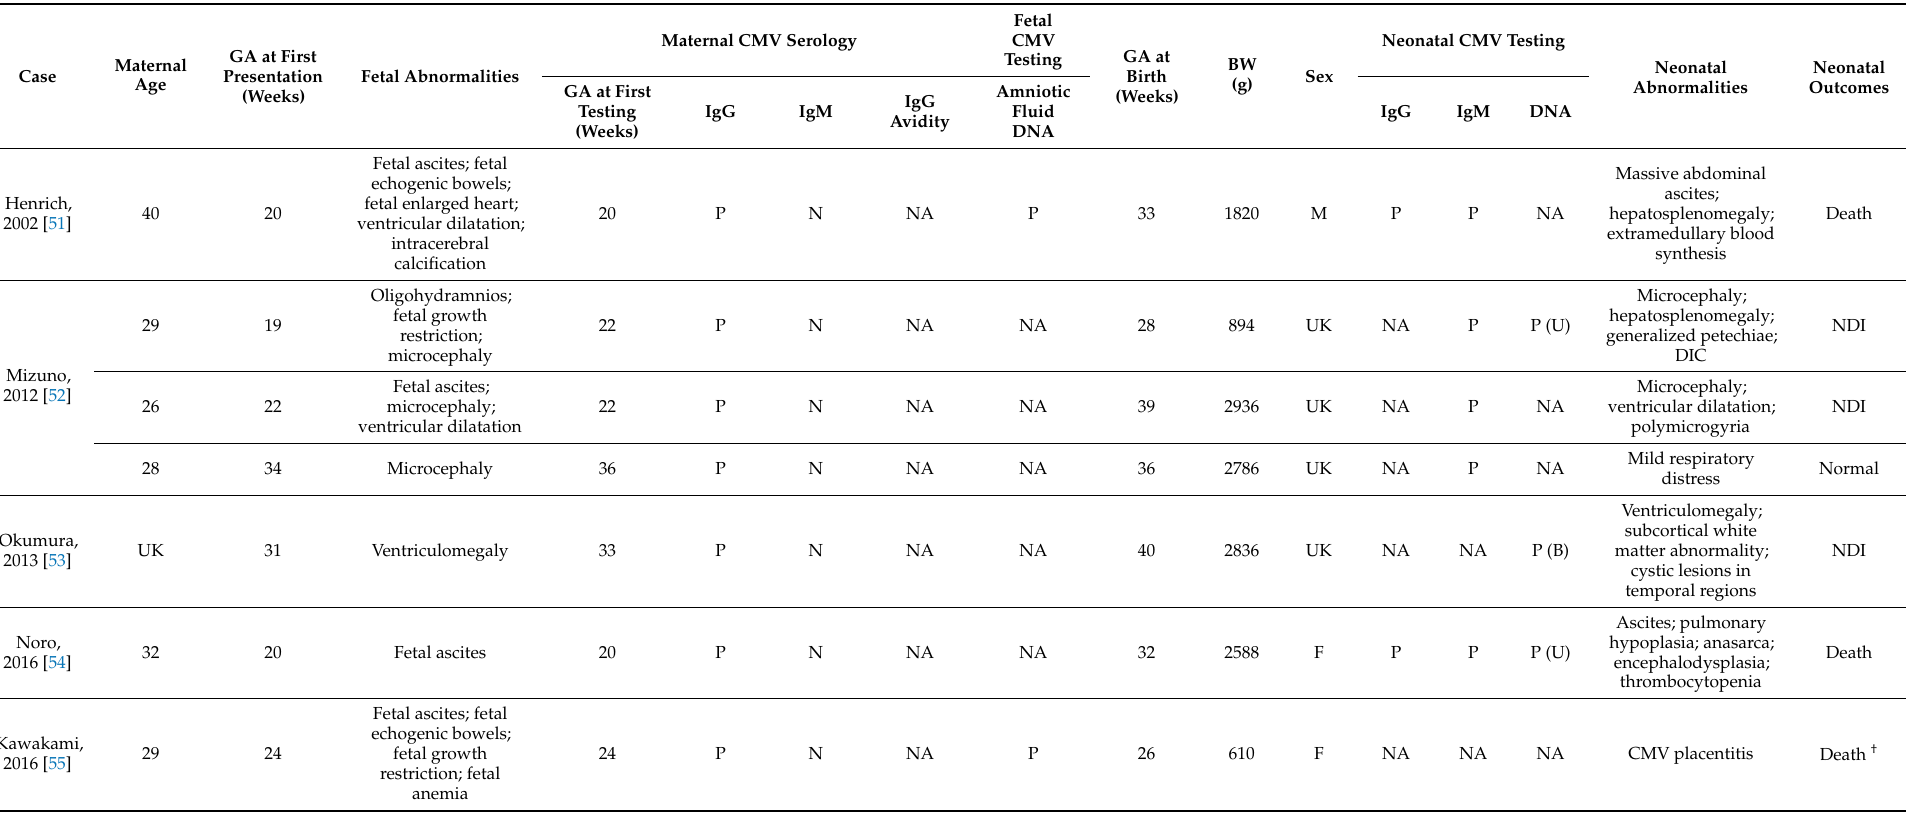
Table 2. Cases of symptomatic congenital cytomegalovirus (CMV) infection in the absence of maternal CMV-IgM (immunoglobulin M)